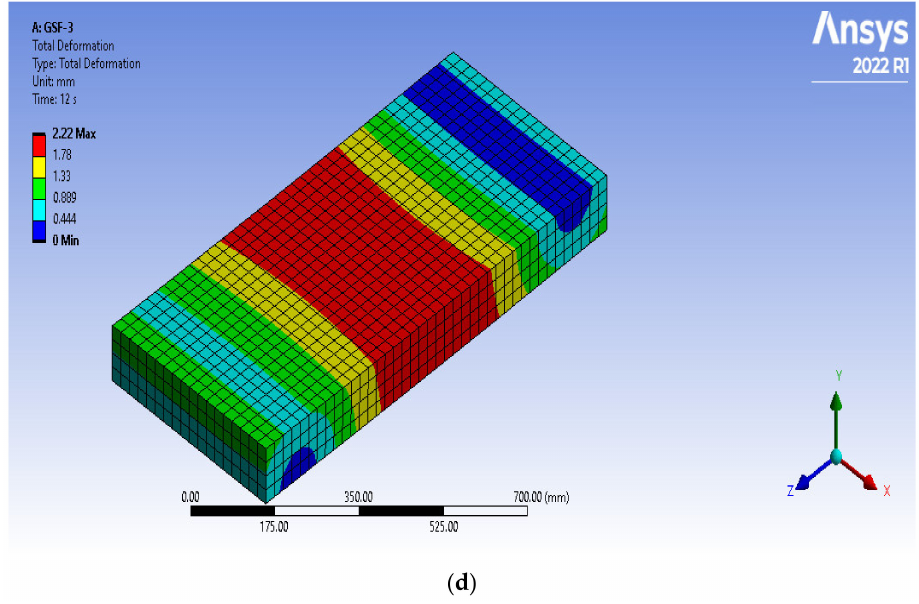
Figure 21. Ultimate deflection of slab ( a ) SRC, ( b ) SRF, ( c ) GSC-3, ( d ) GSF-3.